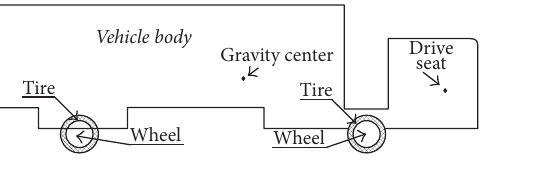
Figure 1: Simplified vehicle model.